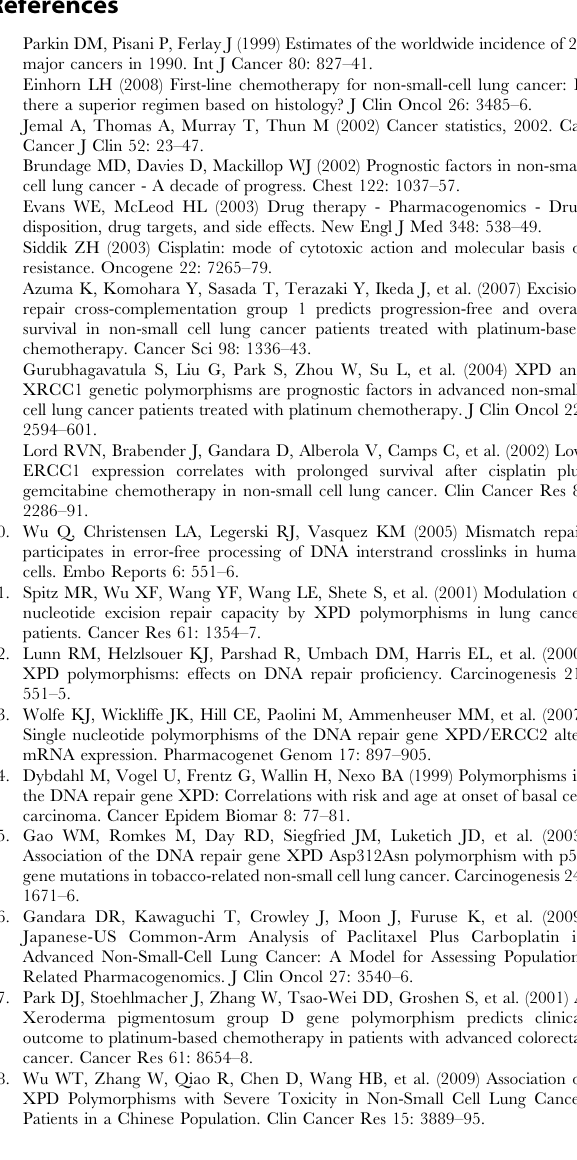
Table S3 Haplotype distribution according to clinical factors.